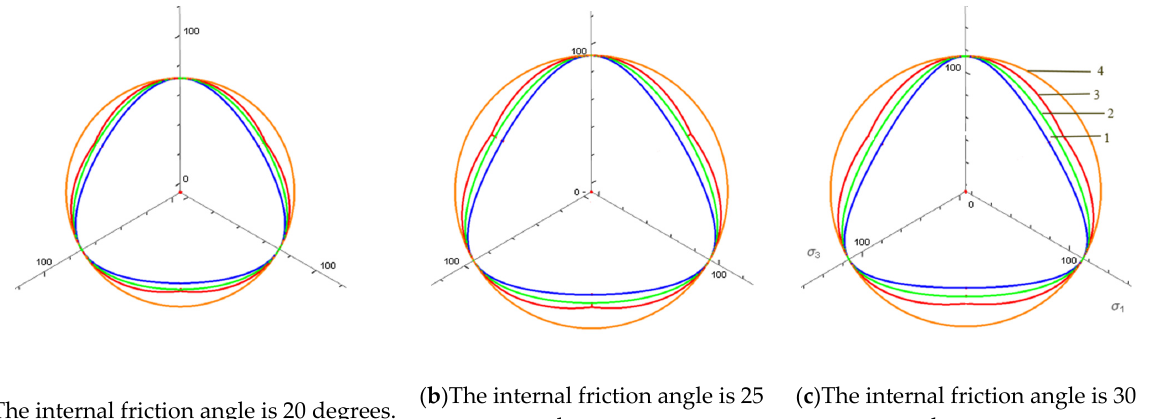
Figure 2. The failure envelope of each strength criterion in π plane under different internal friction angles, 1—SMP criterion; 2—L-D criterion; 3—AC-SMP criterion; 4—D-P criterion. ( a ) The internal friction angle is 20 degrees; ( b ) The internal friction angle is 25 degrees; ( c ) The internal friction angle is 30 degrees.